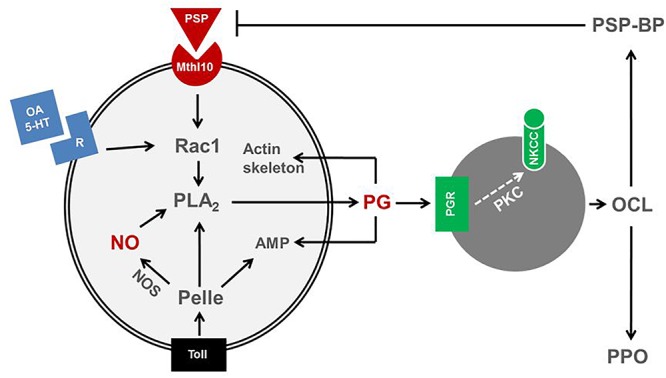
Cross-talk among immune mediators in insects. A cytokine, plasmatocyte-spreading peptide (PSP) binds to its receptor, methuselah 10 (Mthl10) activates a small G protein, Rac1, which is also activated by biogenic monoamines, octopamine (OA) or 5-hydroxytryptamine (5-HT). Rac1 activates PLA2 to produce prostaglandin (PG). PLA2 is also activated by a protein kinase, Pelle, which is activated by Toll receptor. The Toll pathway also induces nitric oxide synthase (NOS) or antimicrobial peptide (AMP) genes. NOS synthesizes nitric oxide (NO) and activates PLA2. The activated PLA2 is involved in PG biosynthesis. PG triggers oenocytoid cell lysis (OCL) and release PSP-binding protein (PSP-BP) and prophenoloxidase (PPO). OCL is induced by sodium-potassium-chloride cotransporter (NKCC) via protein kinase C (PKC). PSP-BP facilitates PSP degradation. PG also mediates cytoskeletal rearrangement and AMP production.